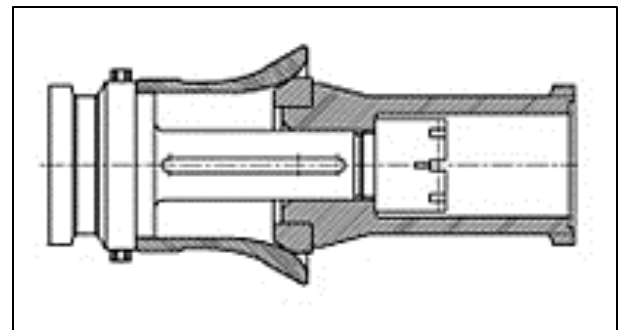
Figure 8. Deformation tube.